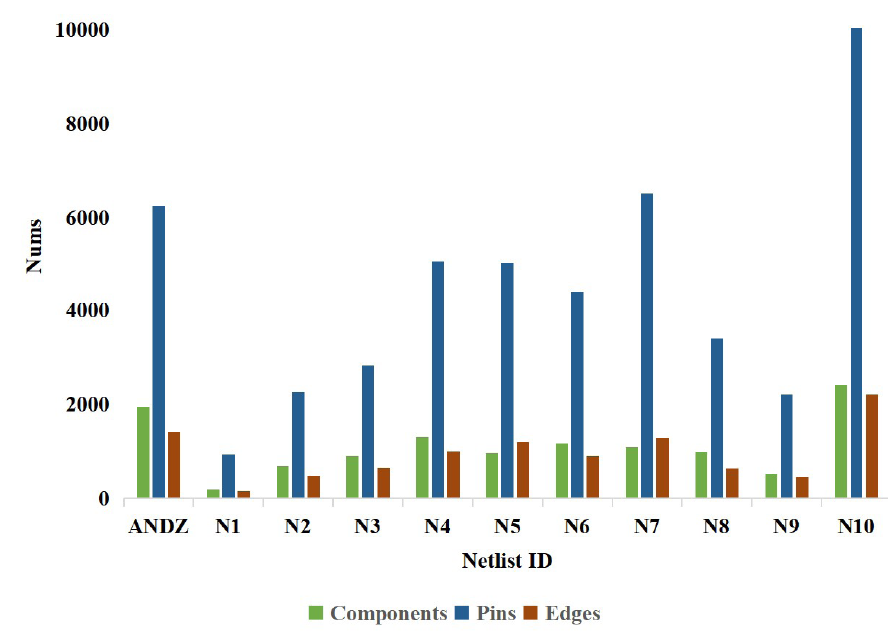
Figure 7. The statistics of components, pins, and edges for the PCB netlist